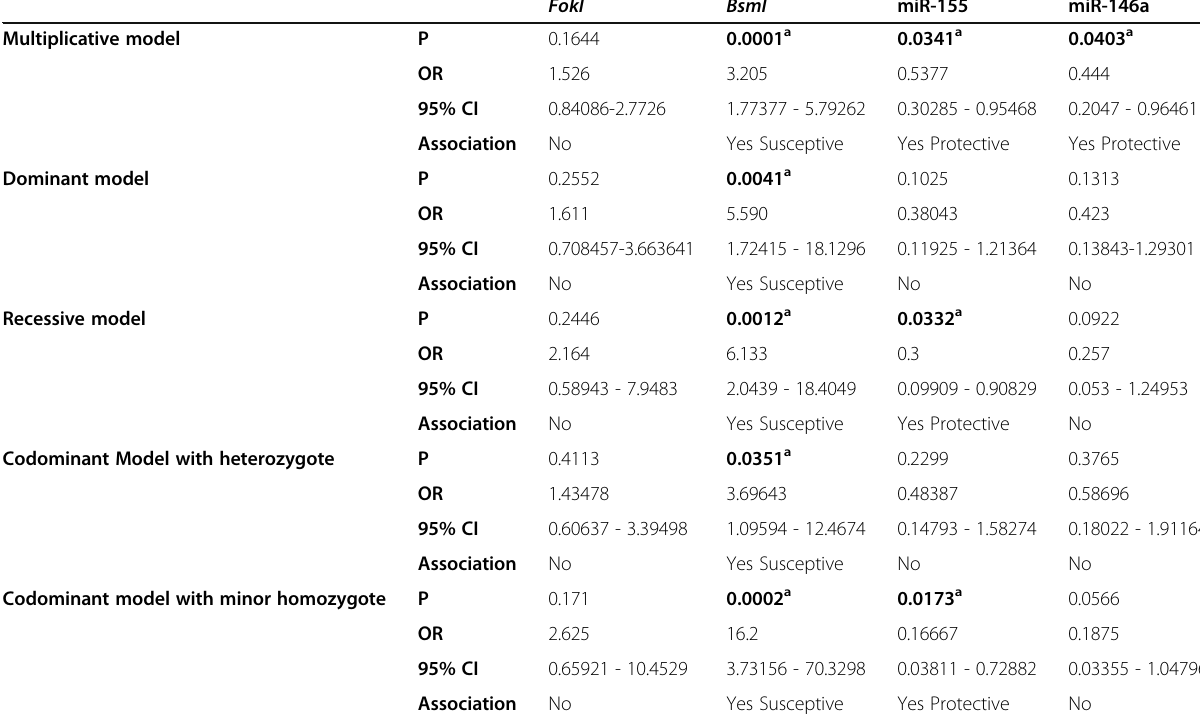
Table 2 Case-2 control study and SNP